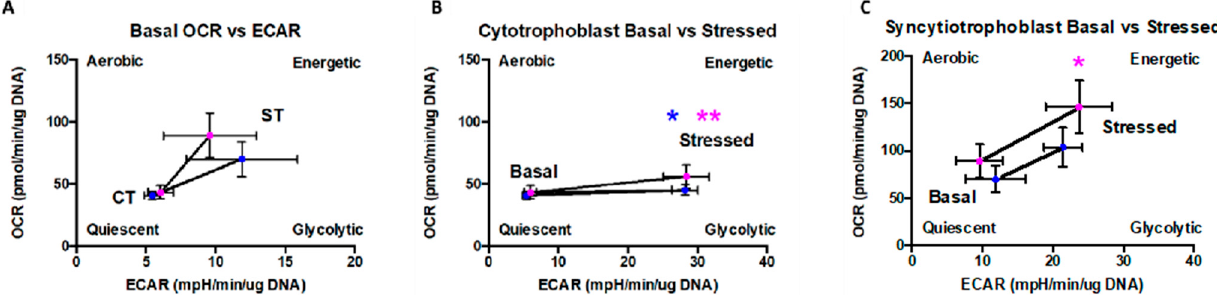
Figure 4. Comparison of metabolic phenotypes of CT and ST. ( A ) Metabolic shift of CT to ST and metabolic potential of ( B ) CT and ( C ) ST. Data presented as mean +/ − SEM. Male (blue, n = 8) and female (pink, n = 8) groups separated. * p < 0.05, ** p < 0.01, Wilcoxon signed-rank test.